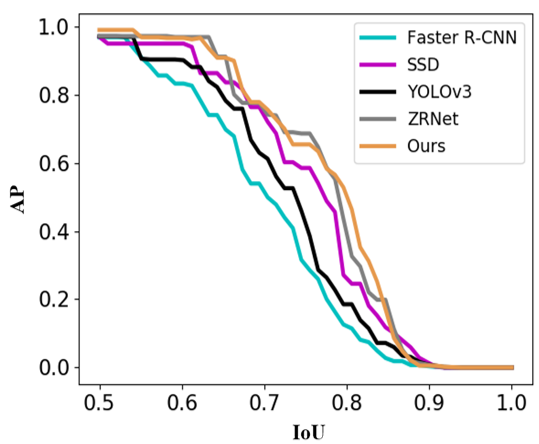
Figure 8. AP curves of different detection algorithms and our approach.